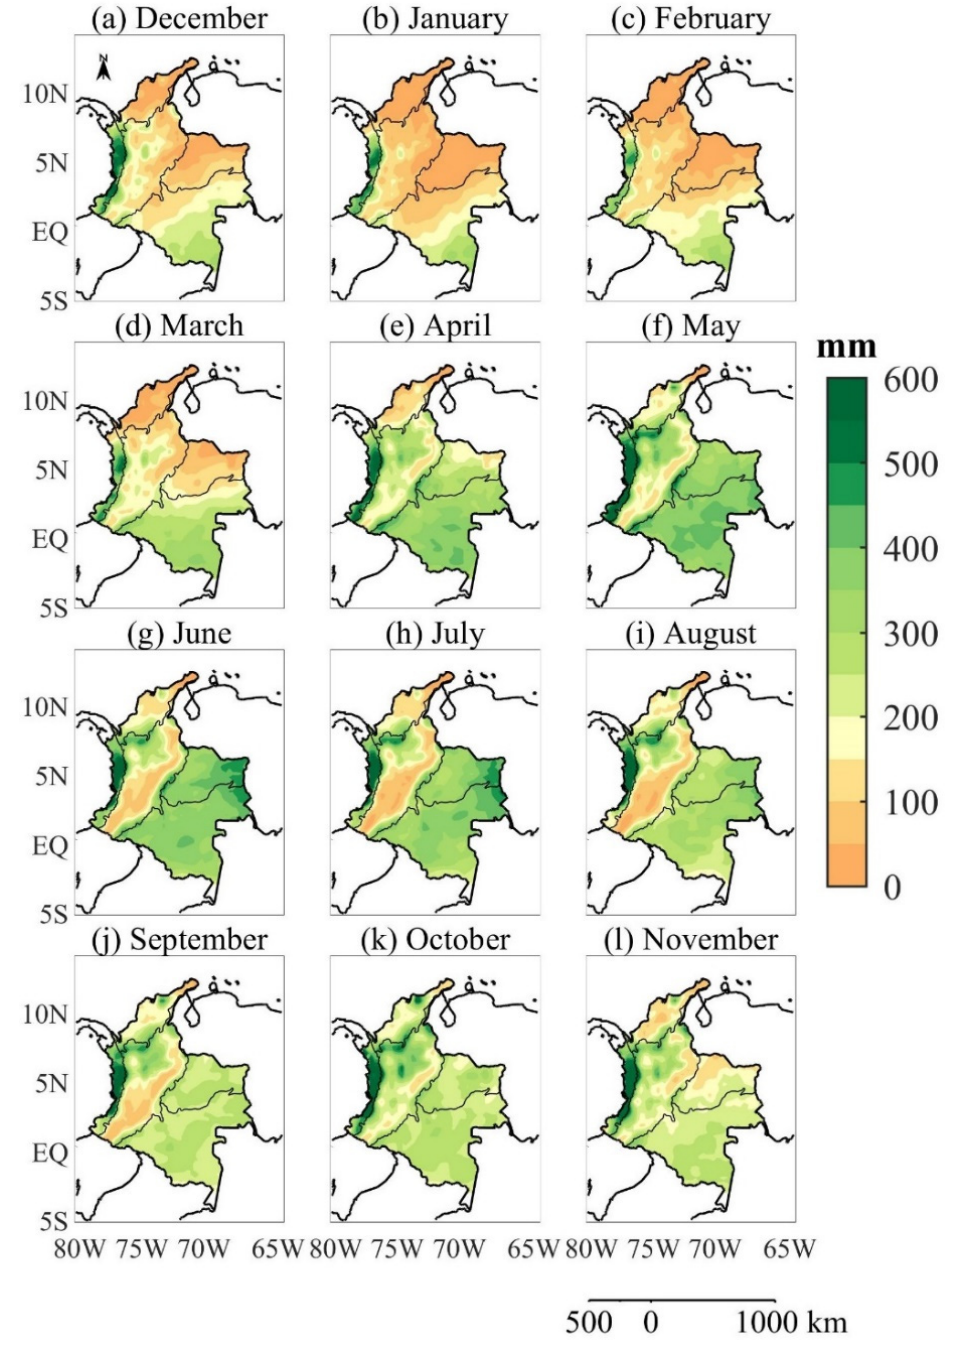
Figure 2. Monthly rainfall climatology (mm) in Colombia for the 1981–2018 period from CHIRPS dataset for ( a ) December, ( b ) January, ( c ) February, ( d ) March, ( e ) April, ( f ) May, ( g ) June, ( h ) July, ( i ) August, ( j ) September, ( k ) October, and ( l ) November. May and October–November periods, and minima in January–February and